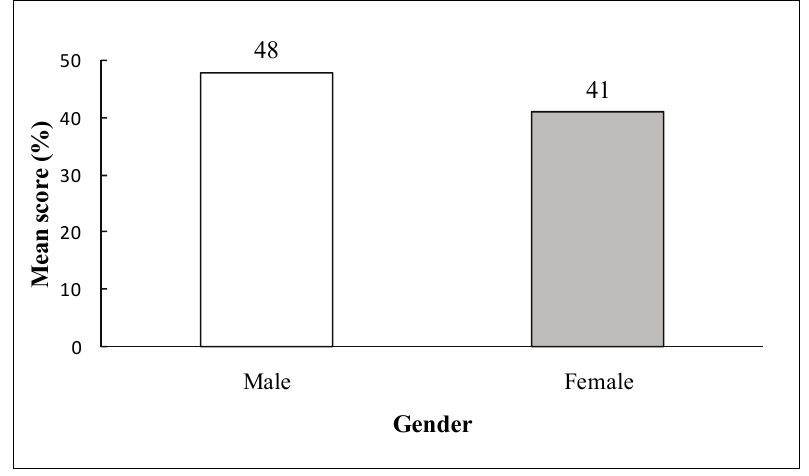
Figure 3 : Gender difference in mean scores in